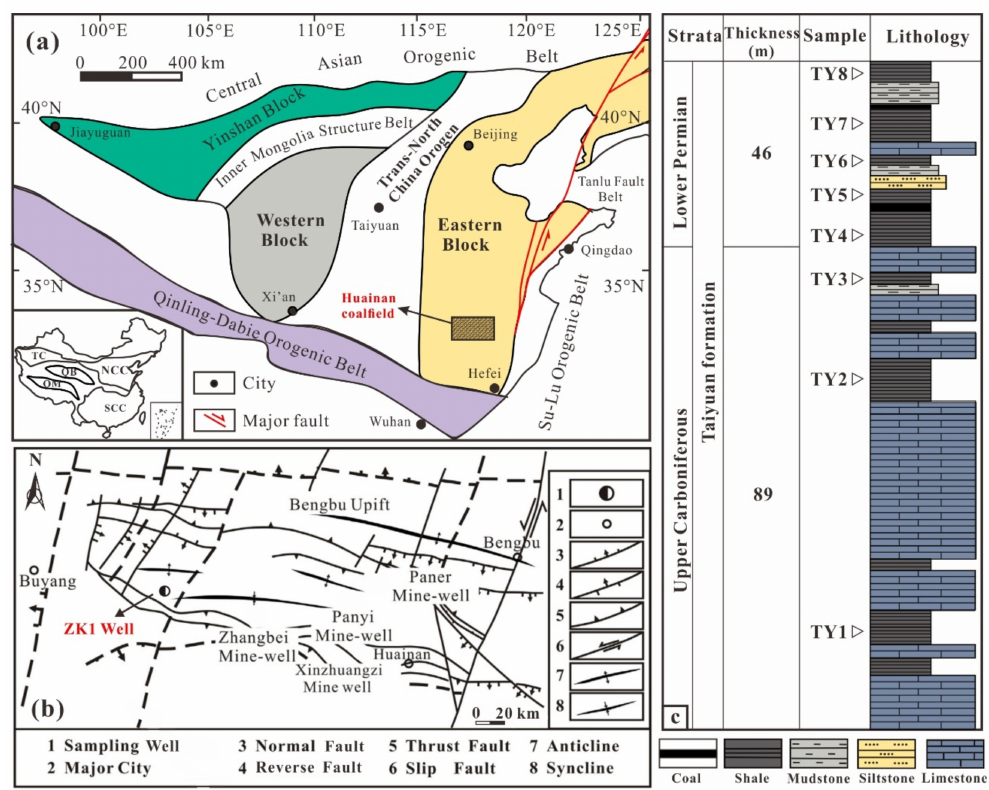
Figure 1. Tectonic map of North China ( a ) [35], sampling well location, detailed structural subdivisions of folds and faults ( b ) [37], and general lithostratigraphic column of the Taiyuan Formation and sampling position of ZK1 well ( c )